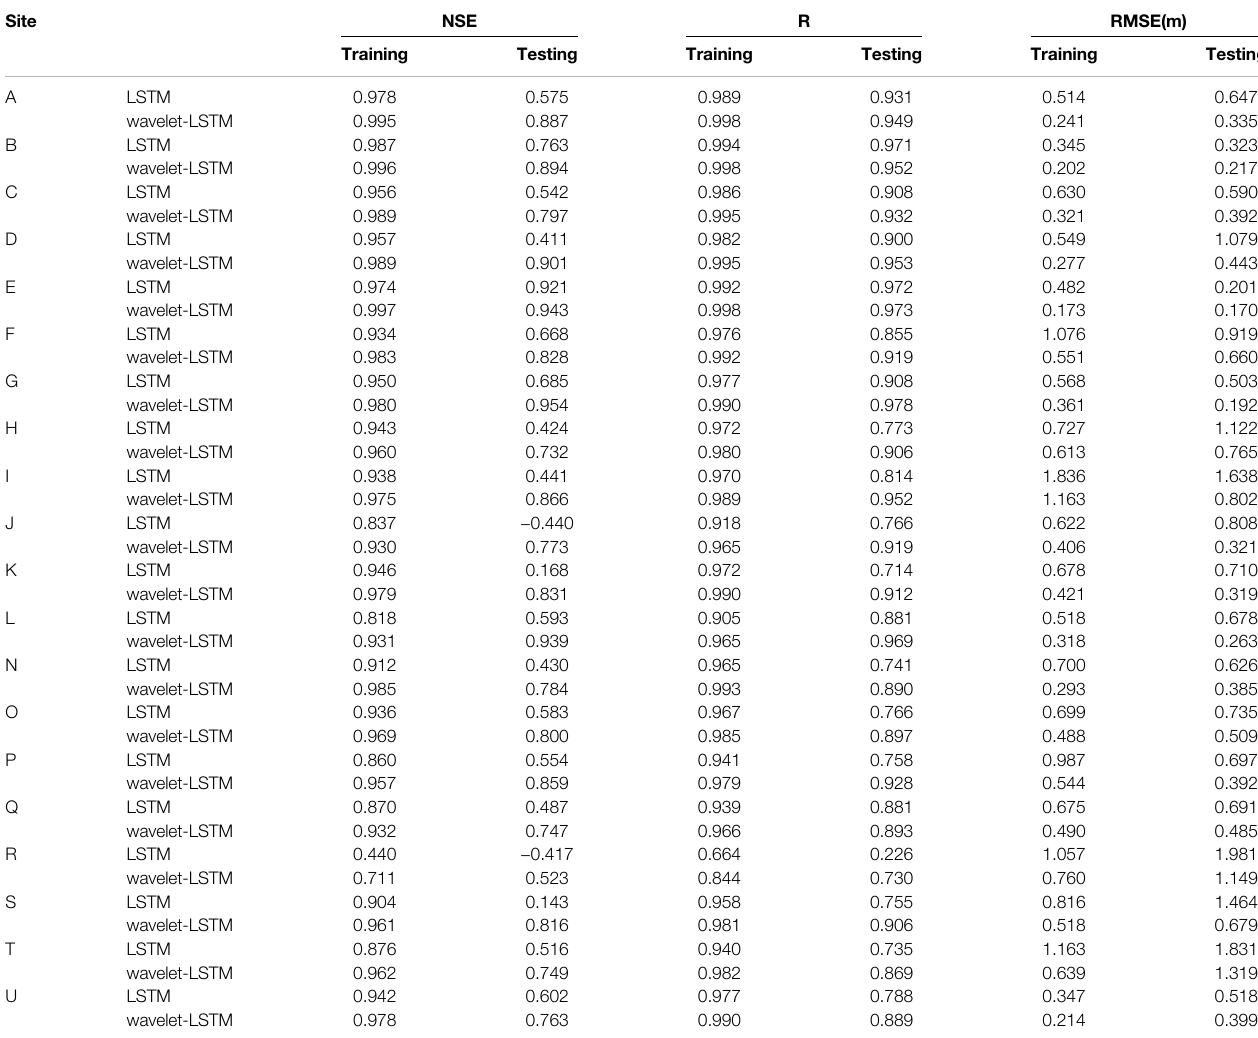
TABLE 1 | Comparison of performance between LSTM model and wavelet-LSTM model.